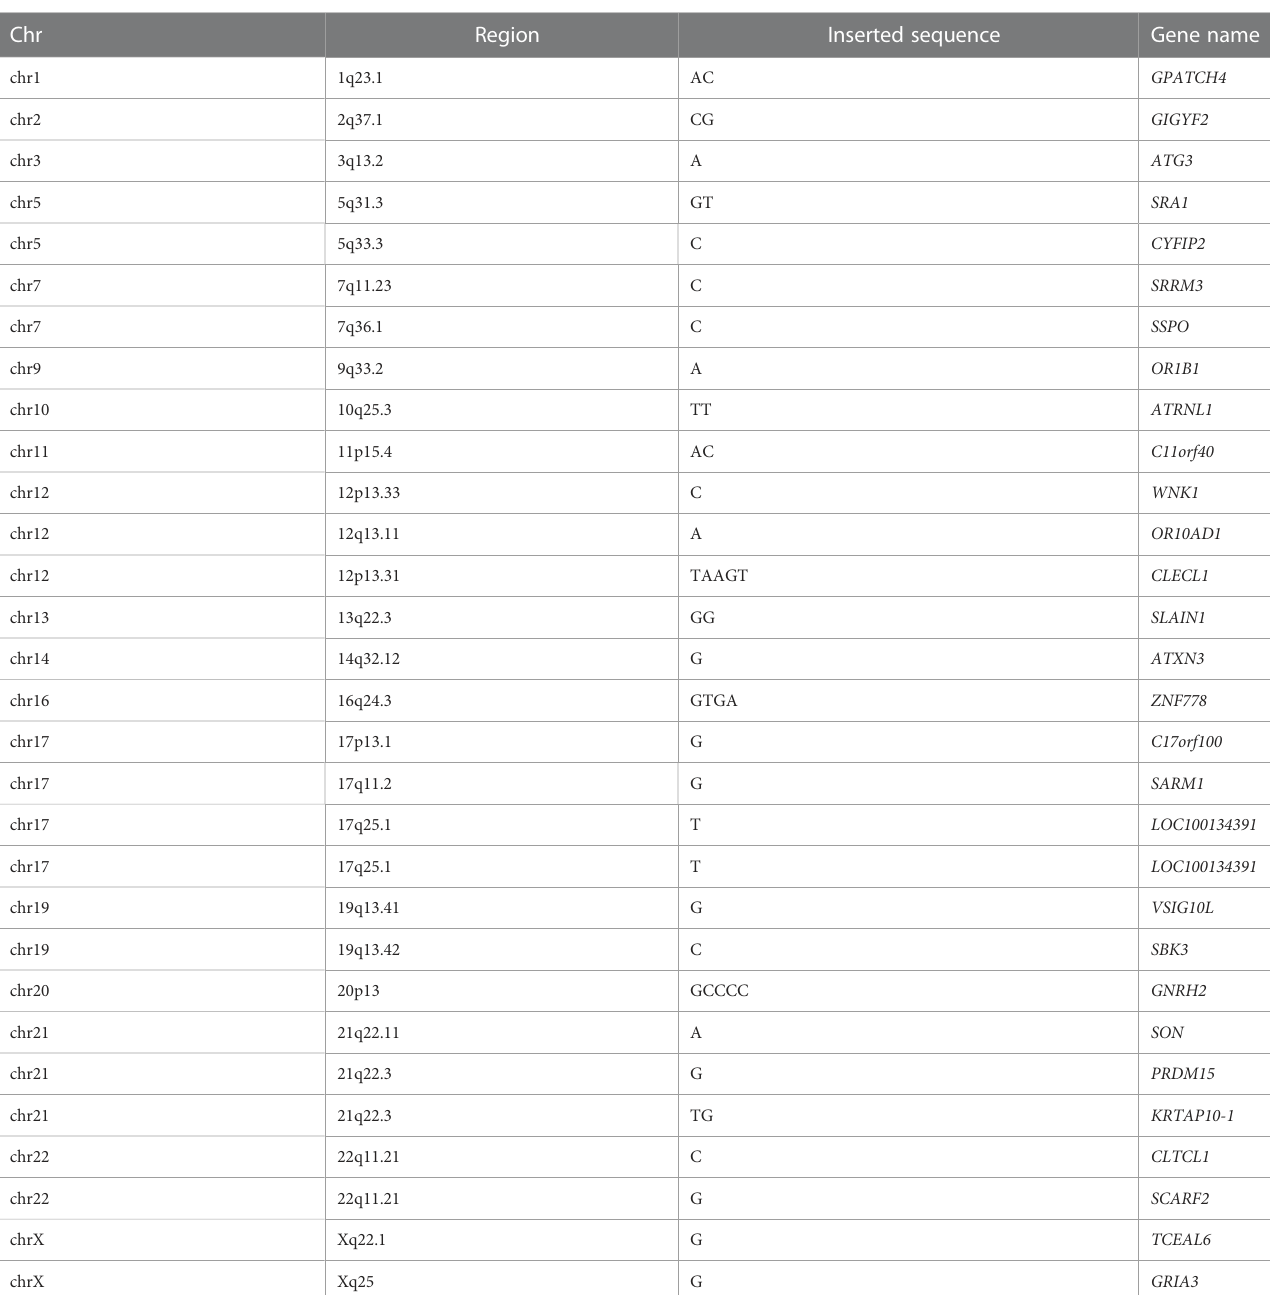
TABLE 4 The common genes with frameshift insertions. Chr